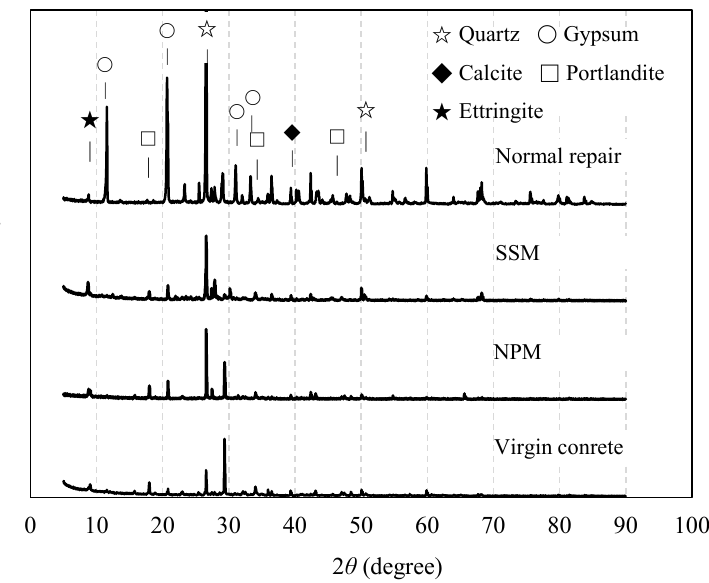
Figure 13. XRD patterns at the surface layer of coated concrete samples immersed in 5% sulfuric acid solution for 28 days.